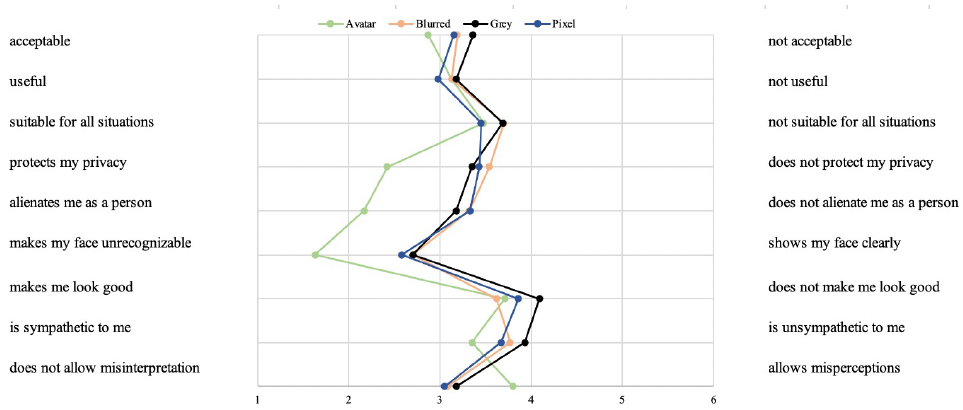
Figure 8. Affective evaluation of different visualizations of video-based AAL technology (n =